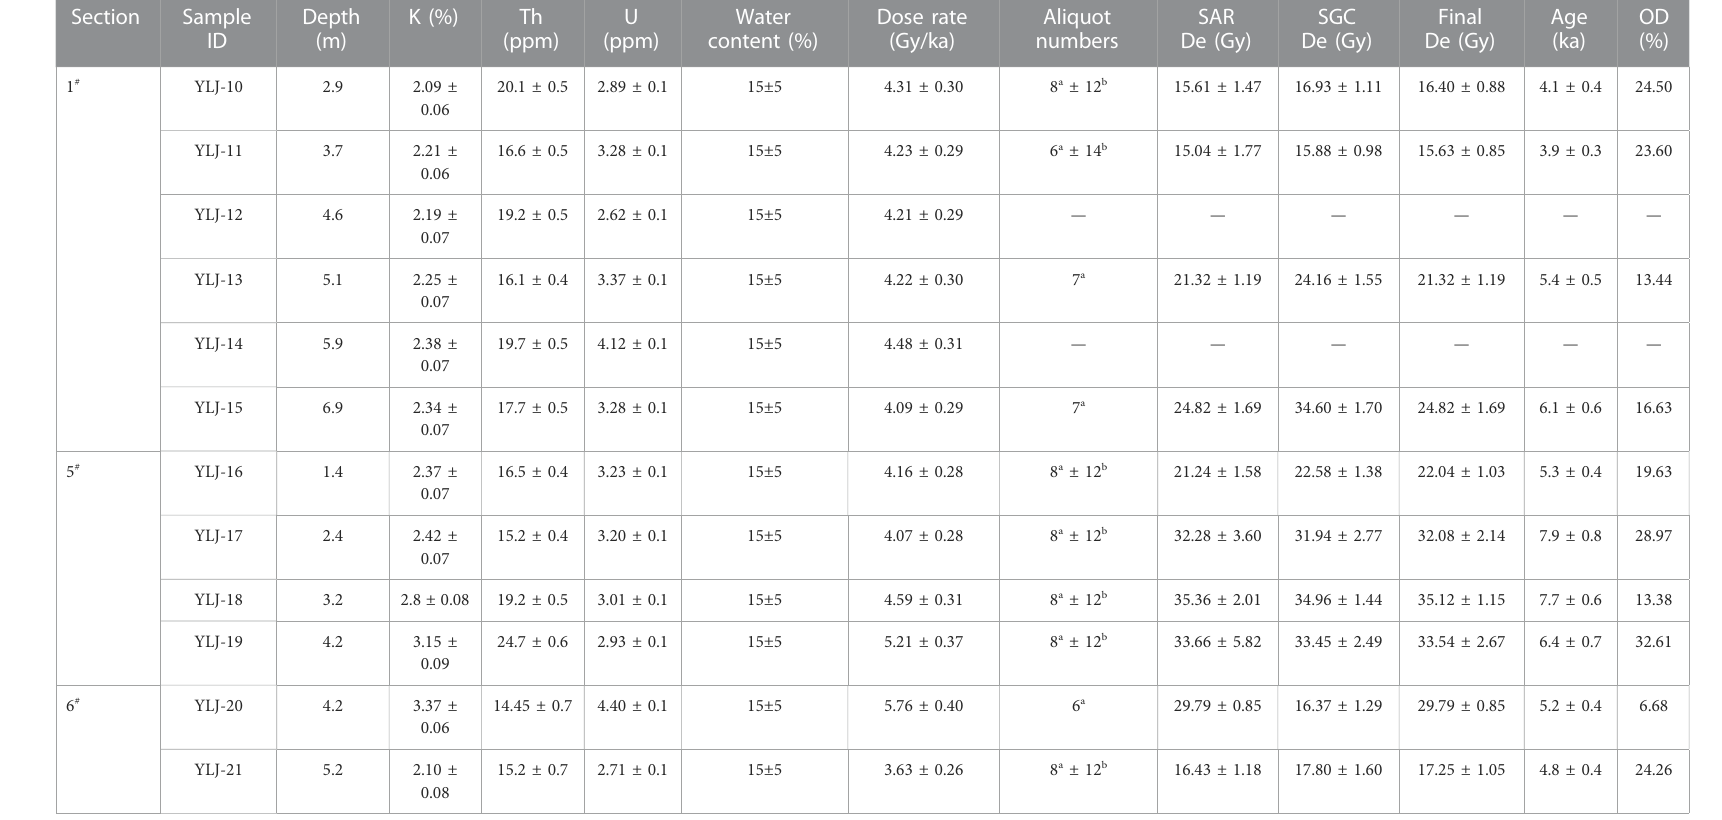
TABLE 2 Paleodose, dose rate, and ages obtained from quartz extracted from deposits.